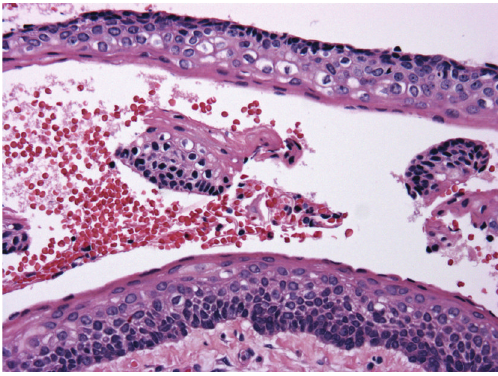
Figure 1: Picture of keratocyst showing typical epithelial lining with basal palissading and corrugating parakeratinized